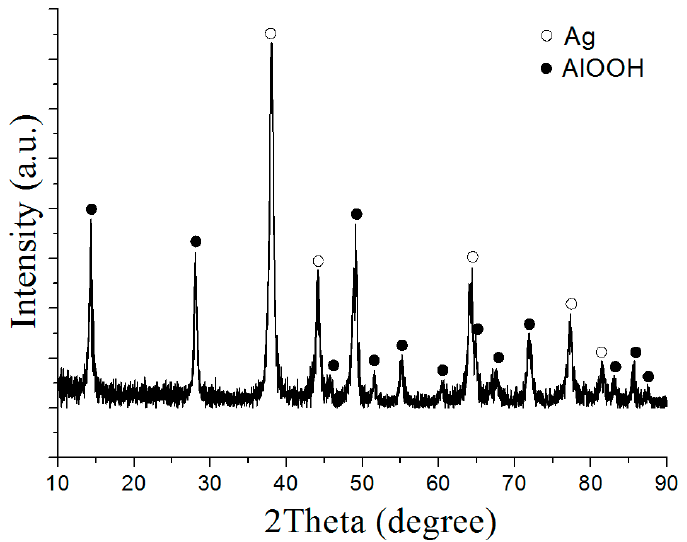
Figure 8. XRD pattern of the nanoscale structures obtained under HTO conditions (sample 3).